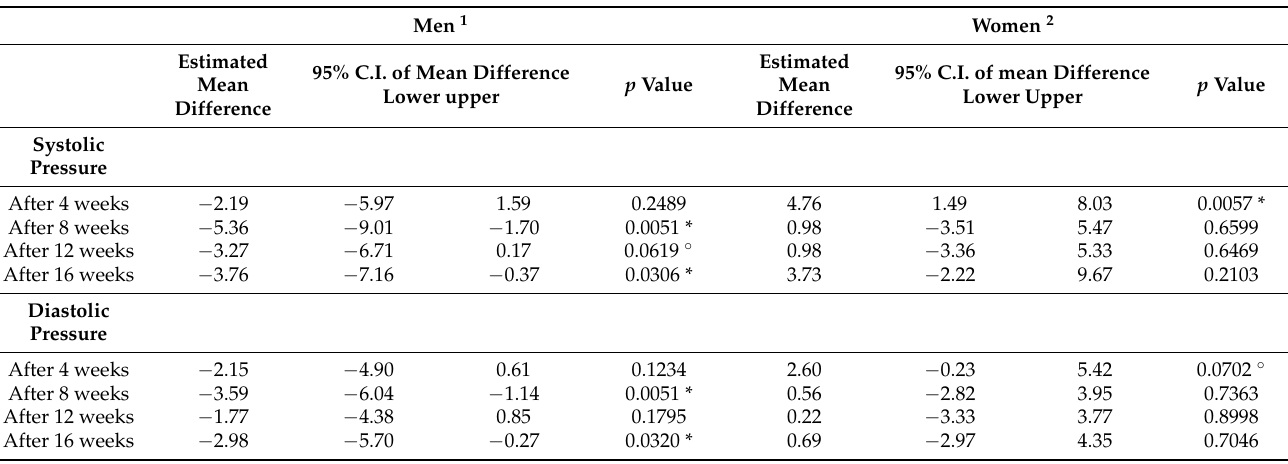
Table 2. Summary of significance levels of pair wise comparisons by gender for baseline-corrected systolic and diastolic blood pressure changes from 7-day